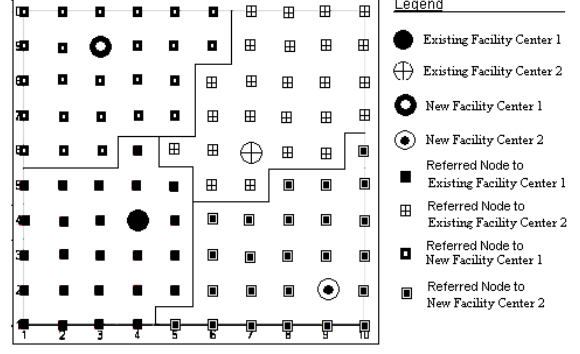
Fig. 5. The result of proposed method